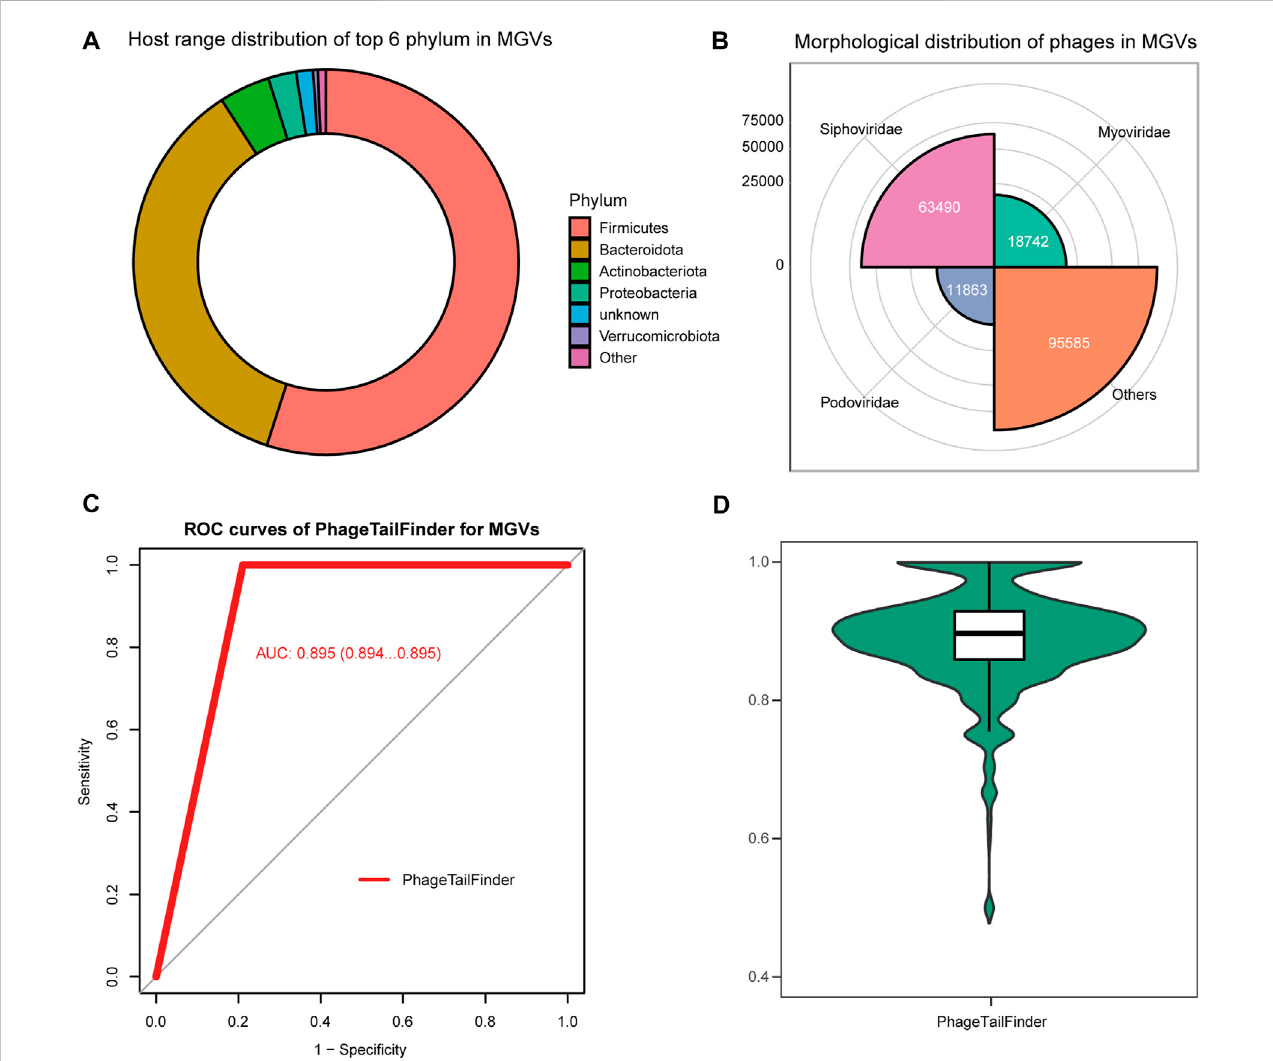
FIGURE 5 PerformanceofthePhageTailFinderinpredictingphageproteininMGVs. (A) TaxonomydistributionofitemsdetectedasphageinMGVs. (B) Morphology distribution of items detected as phage in MGVs. (C) ROC curve showing the predictive power of models in the MGV set, with the AUC value of 0.895. (D) Distribution of the AUC values per phage using the